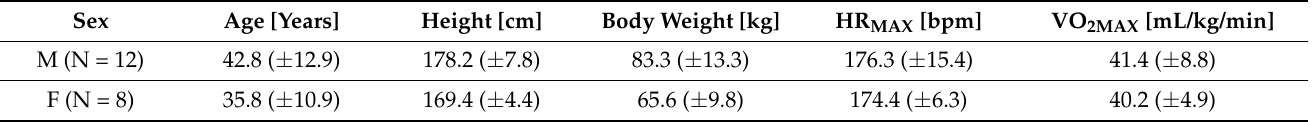
Table 1. Demographic data of all included participants (N = 20), with sex, age, height, body weight, maximum heart rate (HR MAX ), and VO 2MAX seen during the incremental test. Mean ± standard deviations (SD) listed.